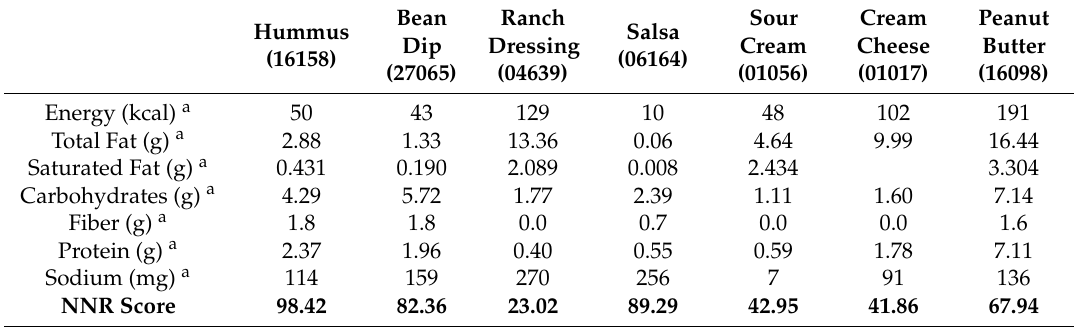
Table 2. Nutritional profile and NNR scores of hummus and other common spreads and